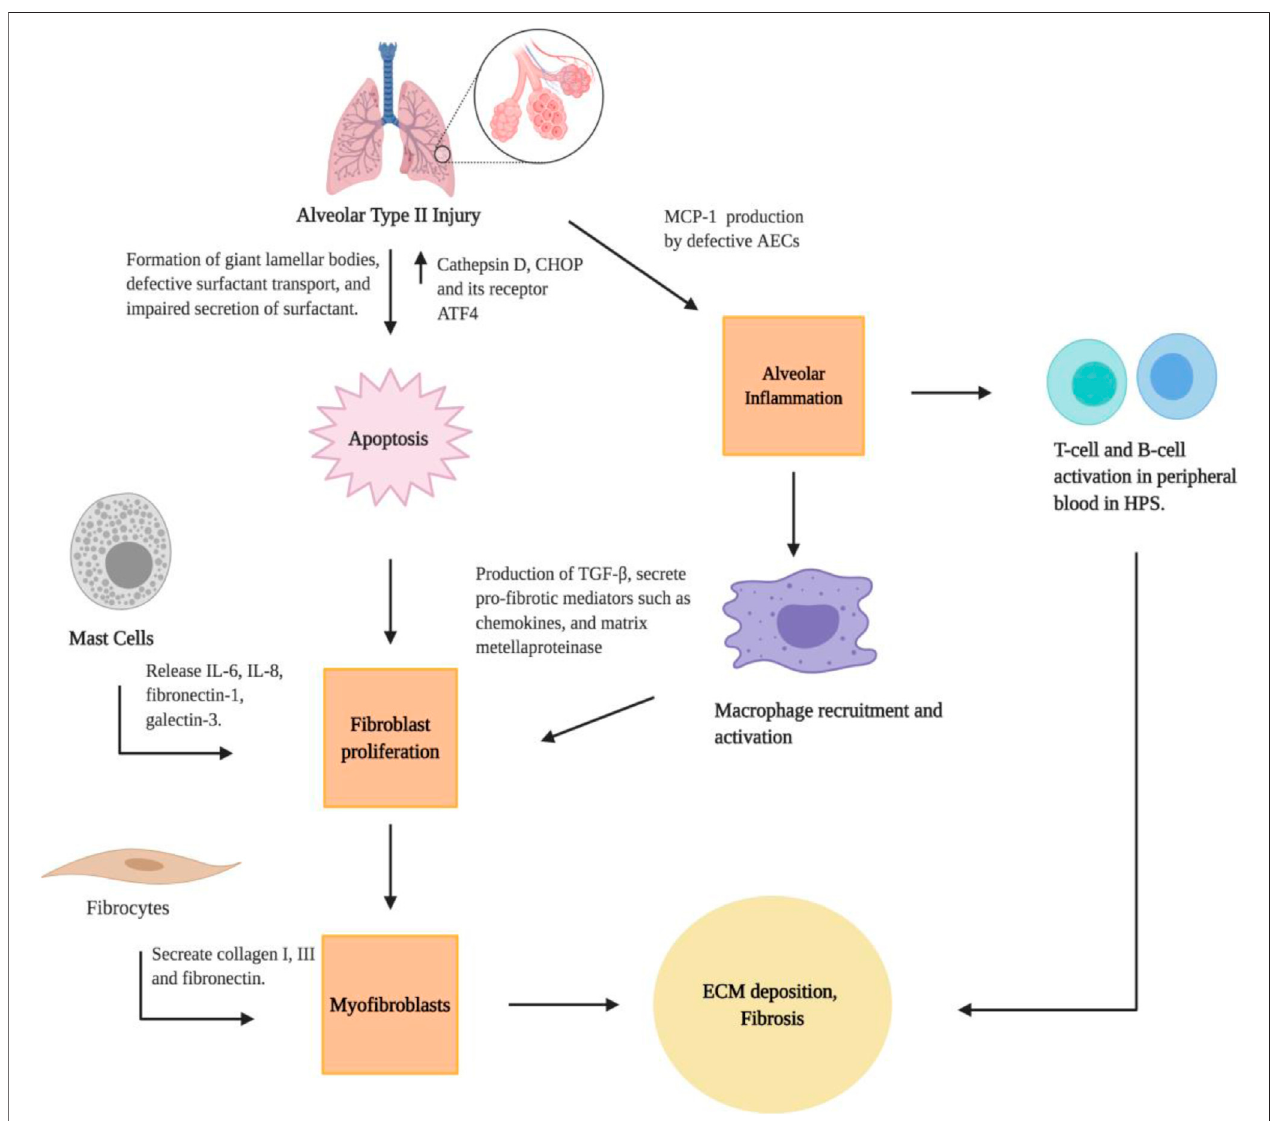
FIGURE 2 | Cellular pathways for the development of lung fi brosis in HPS. Created with BioRender.com.